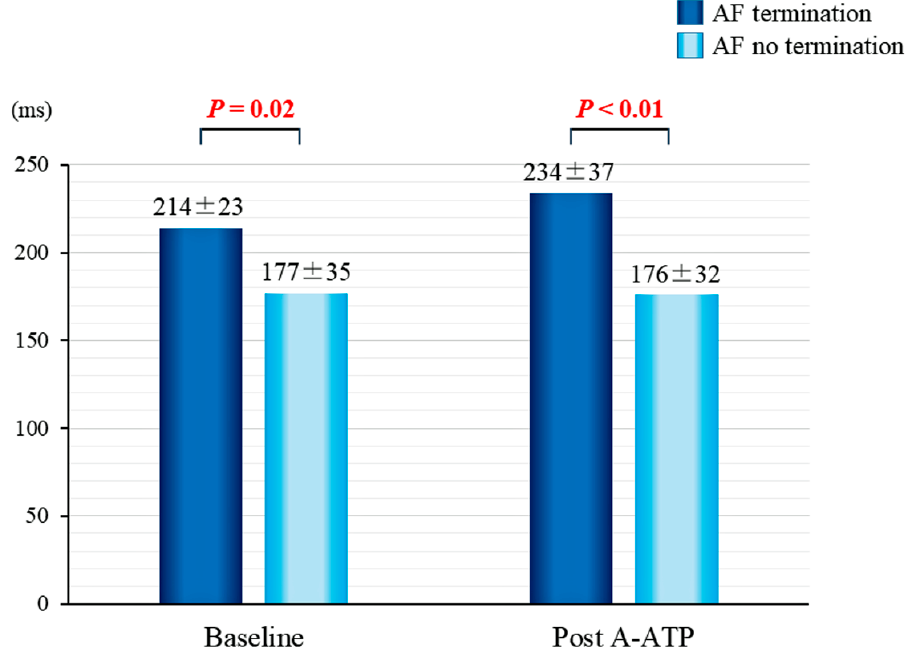
Figure 5. Mean AF CL at baseline and post A-ATP. AF = atrial fibrillation; A-ATP = atrial anti-tach- ycardia pacing; CL = cycle length. tachycardia pacing; CL = cycle